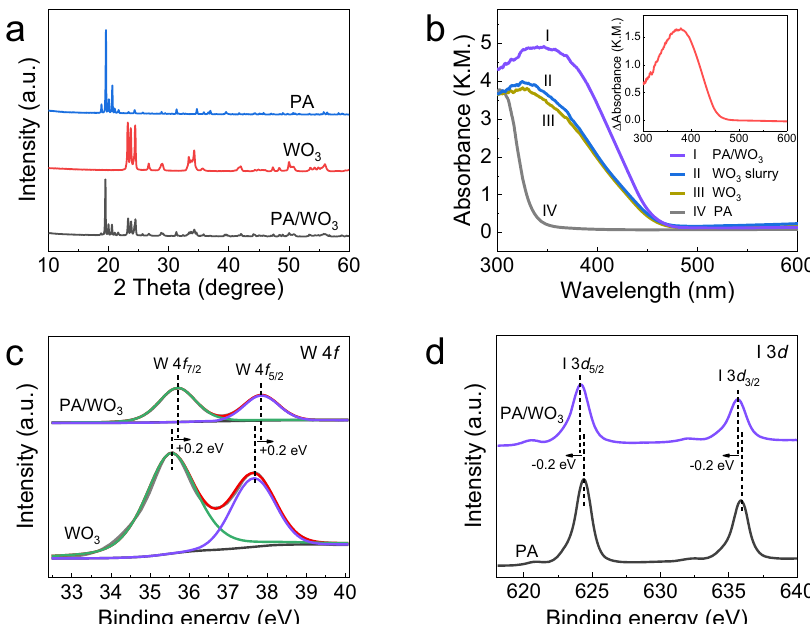
Fig. 4 Characterizations of PA, WO 3 , and PA/WO 3 . a X-ray diffraction spectra. b Diffuse re fl ectance UV – visible absorption spectra (DRS) (Inset is the difference DRS spectrum which is obtained from the spectrum I minus the spectrum III). XPS spectra of c W 4 f and d I 3 d